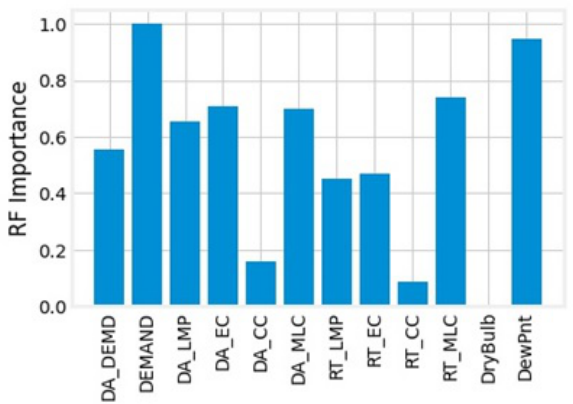
Figure 6. Feature importance calculated by XGB.